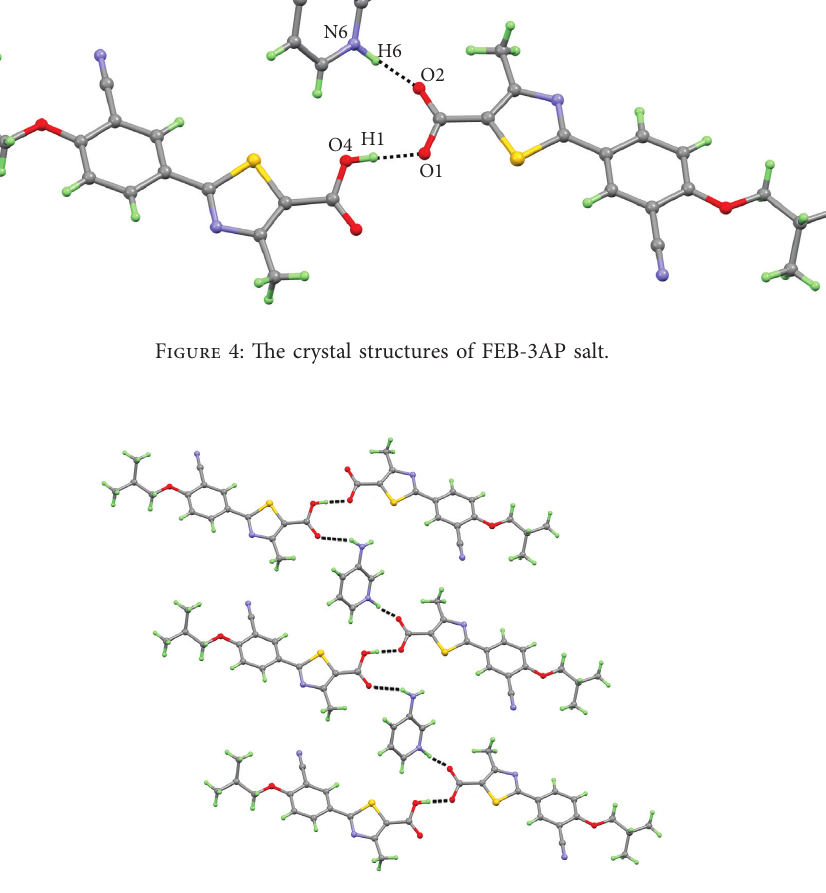
Figure 5: The zigzag chain structures of FEB-3AP